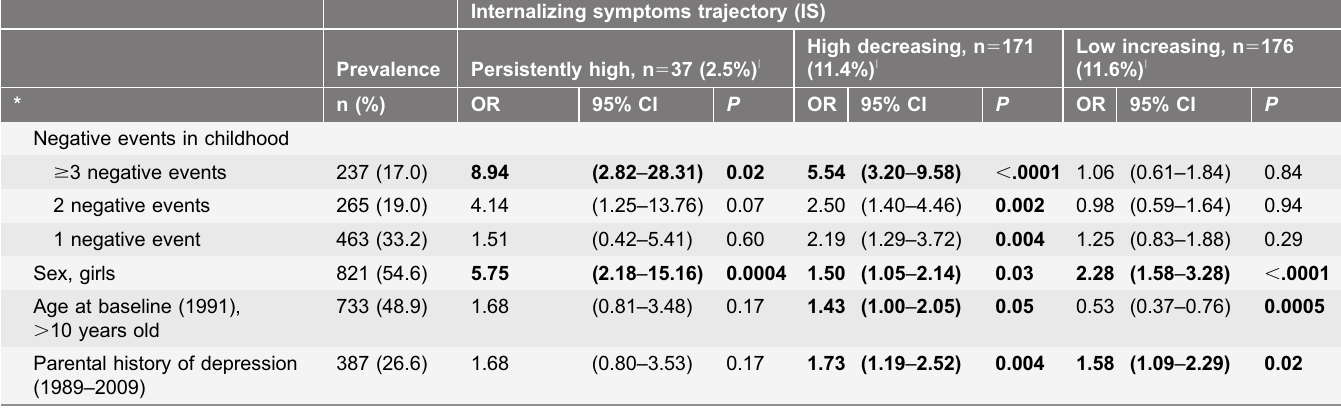
Table 2. Negative childhood events and internalizing symptoms trajectories (French TEMPO study, 1991–2009, n 5 1503, multivariate ORs, adjusted for sex, age at baseline and parental depression, 95% CI).